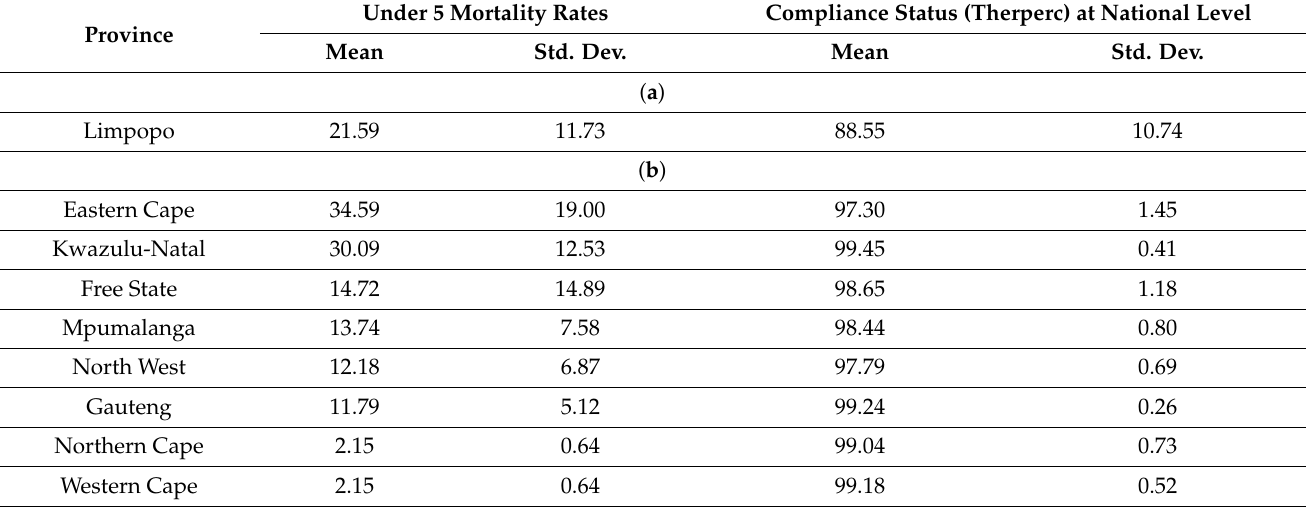
Table 1. Descriptive statistics for children under 5 years mortality rates and their corresponding compliance status (therperc) for per province. ( a ) Limpopo province, ( b ) other provinces. Under 5 Mortality Rates Compliance Status (Therperc) at National Level Province